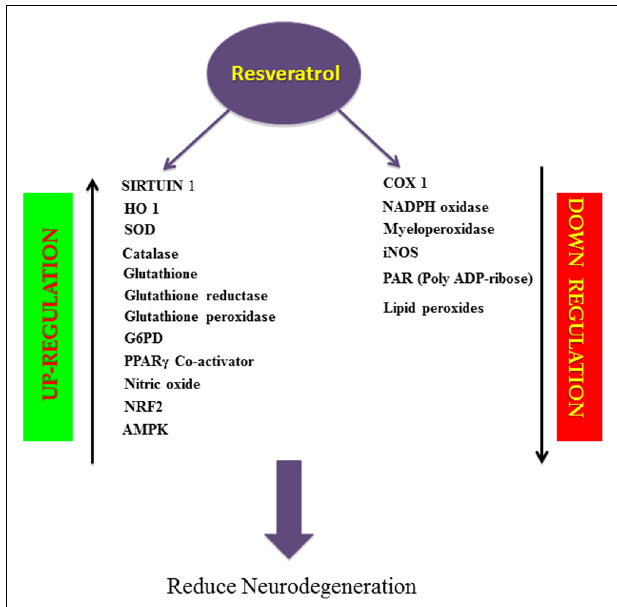
FIGURE 2 | Schematic overview of biological activity of resveratrol. Resveratrol, a natural antioxidant, upregulates the activity of SIRT1, enzymatic antioxidants, PPAR γ Co-activator, NO, NRF2, AMPK and downregulates the activity of COX1, NADPH oxidase, Myeloperoxidase, iNOS, PAR, Lipid peroxides thereby prevents apoptosis and inflammation and reduces